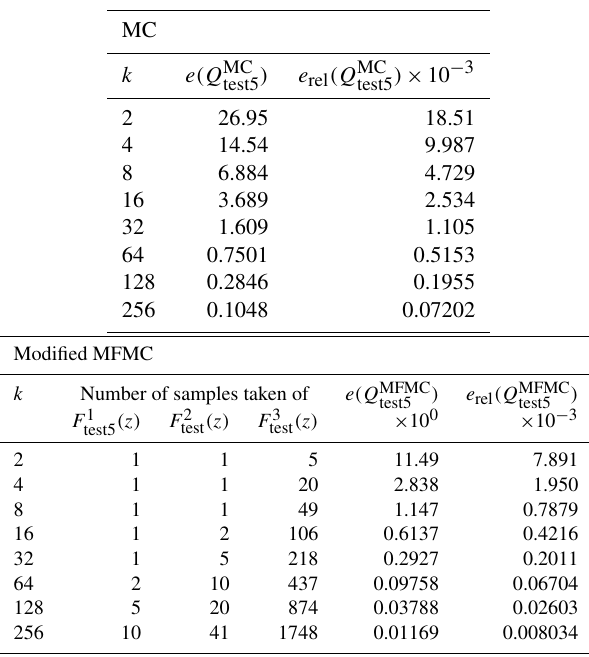
Table 4. Results of Test Case 5 with perturbed initial velocities for budgets B = 2 k C 1 equivalent to 2 k high-fidelity